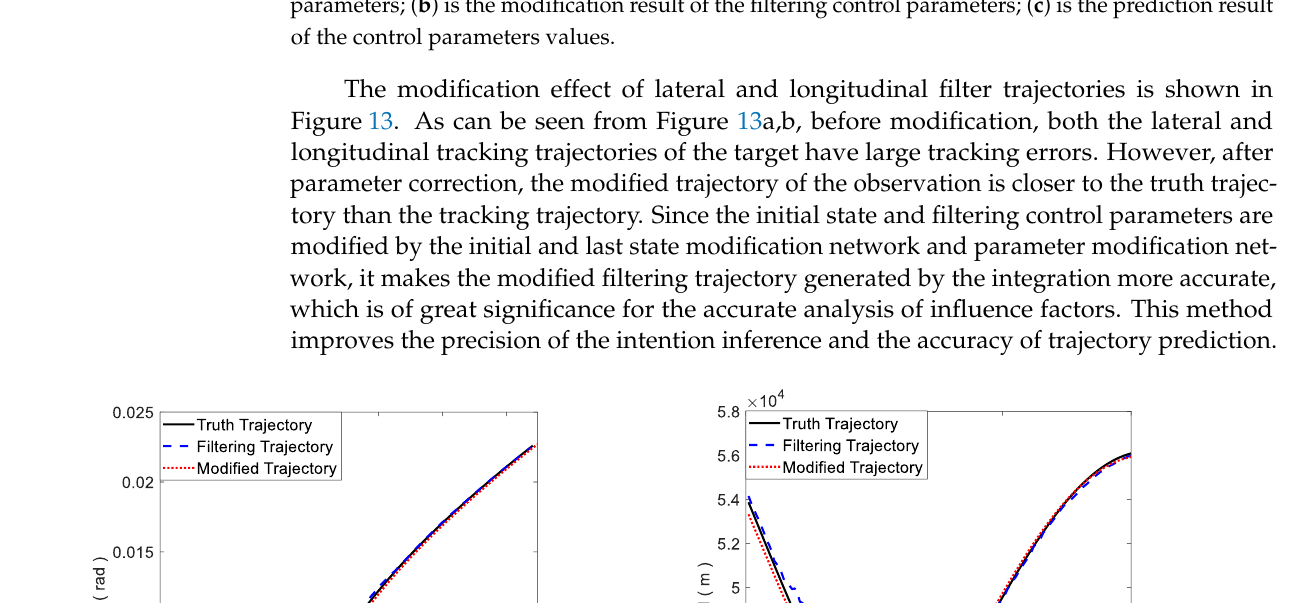
Figure 13. Effect of parameter value network: (a) is the lateral modified filtering trajectory; and (b) is the longitudinal modified filtering trajectory.